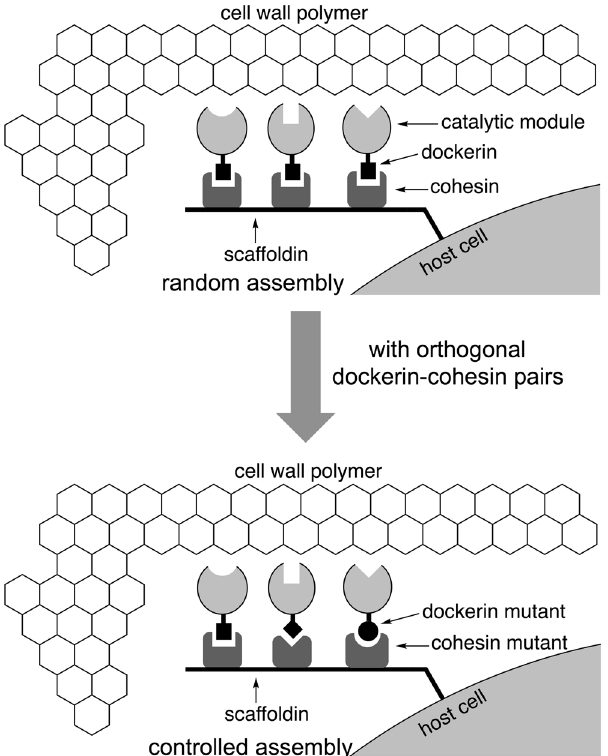
Figure 1. Random and controlled assembly of cellulosome. In nature, the assembly of cellulosomes is mediated by a random attachment of a catalytic module (enzyme), through its dockerin domain, to any cohesin positions on the scaffold protein (scaffoldin). The generation of mutant cohesin-dockerin pairs that are orthogonal to the naturally occurring one may allow a controlled assembly of